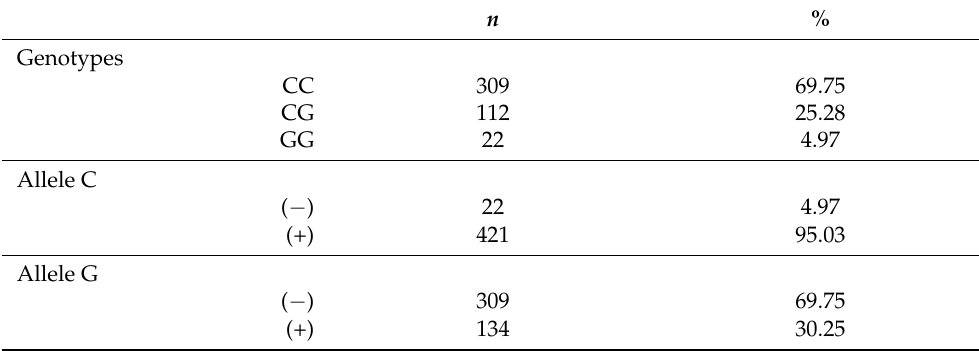
Table 3. Distribution of the genotypes and alleles of the PPAR- γ rs1801282 polymorphism in the study sample ( N = 443).